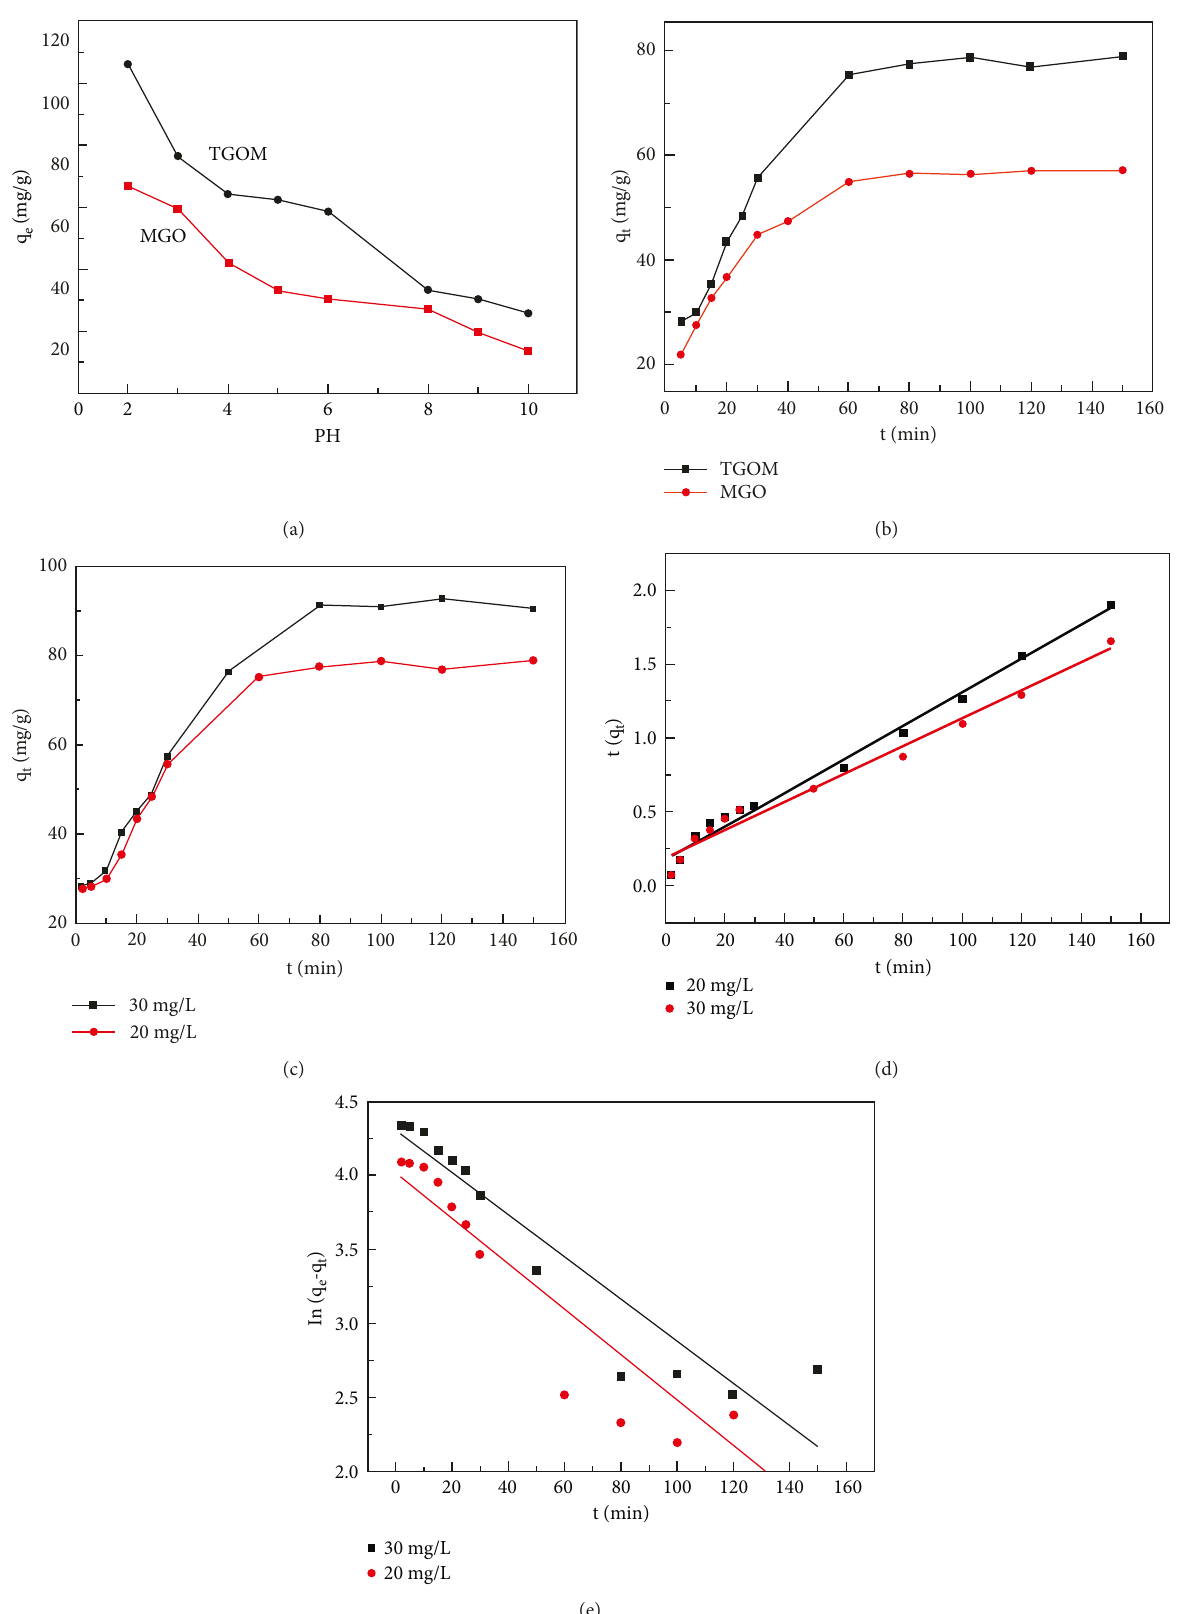
Figure 4: (a) Effect of pH on Cr (VI) removal ( T � 298K, C � 50mg/L, m / V � 0.1 g/L); (b) effect of time on Cr (VI) removal on TGOM and 0 MGO ( T � 298K C 0 � 20 mg/L, m / V � 0.1g/L, pH � 2); (c) effect of time on Cr (VI) removal at different initial concentration ( T � 298K, m / V � 0.1 g/L, pH � 2); (d) pseudo-second-order kinetics graph of Cr (VI) removal; (e) pseudo-first-order kinetics graph of Cr (VI)